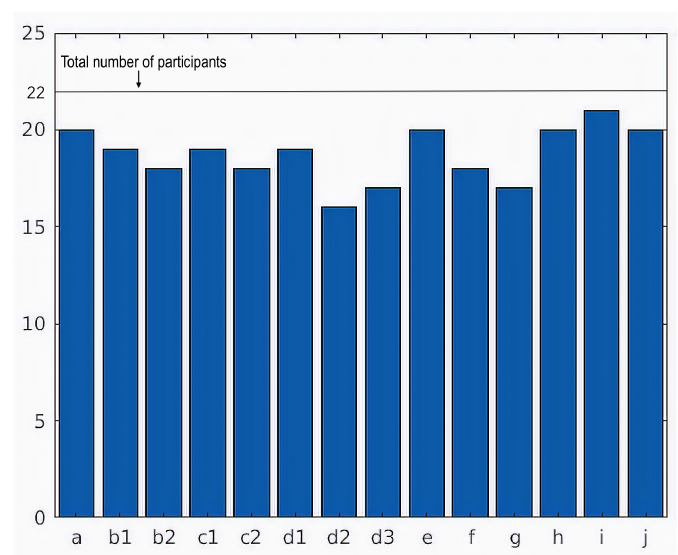
Figure 10. Groups histogram. In the image, each bar illustrates a formation (horizontal axis) and the number of subjects joining that formation (vertical axis). For example, the “a” represents the single VA standing (from Figure 5), 20 subjects joined this formation, and 2 subjects missed this